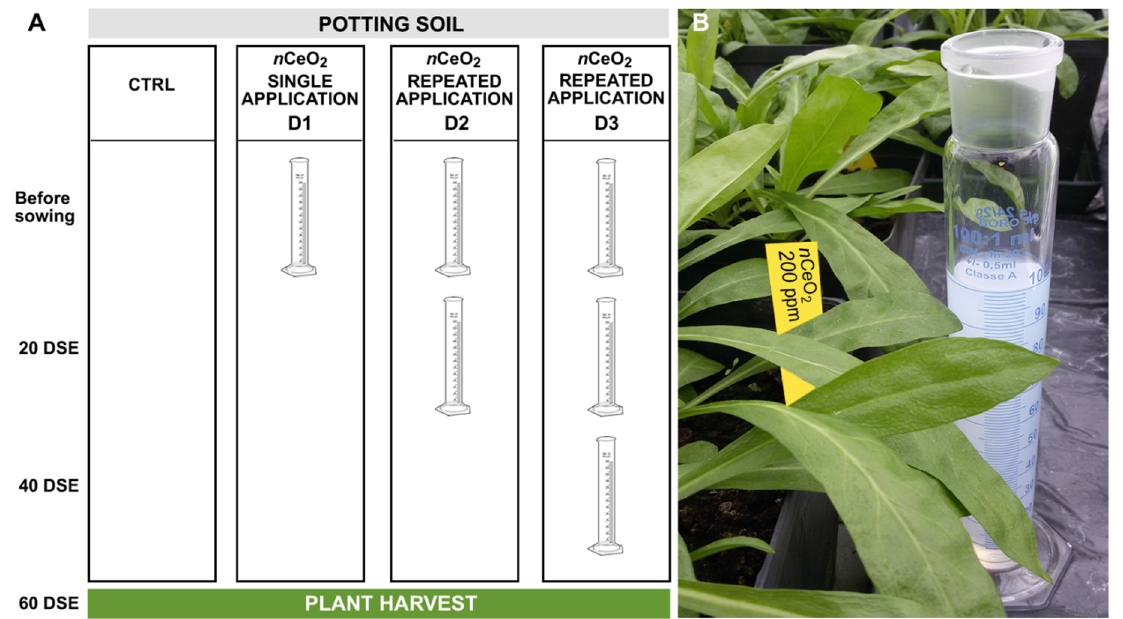
Figure 1. ( A ) Experimental setup showing the combination of treatments: control, single-, double-, and triple-dosed plants (Ctrl, D1, D2, and D3, respectively); ( B ) S. flos-cuculi plants at 40 DSE.